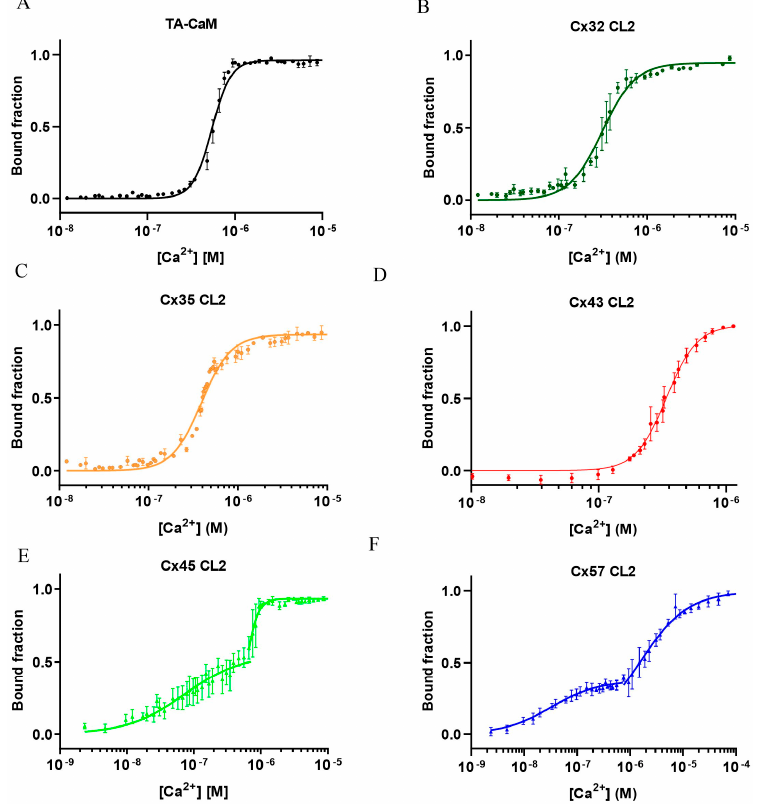
Figure 5. Ca 2+ equilibrium binding of TA-CaM in the presence of Cx CL2 peptides. The bound fraction is plotted against the [Ca 2+ ] concentration. ( A ) TA-CaM; TA-CaM in the presence of ( B ) Cx32 CL2 peptide, ( C ) Cx35 CL2 peptide, ( D ) Cx43 CL2 peptide, ( E ) Cx45 CL2 peptide and ( F ) Cx57 CL2 peptide. The error bars represent SD.